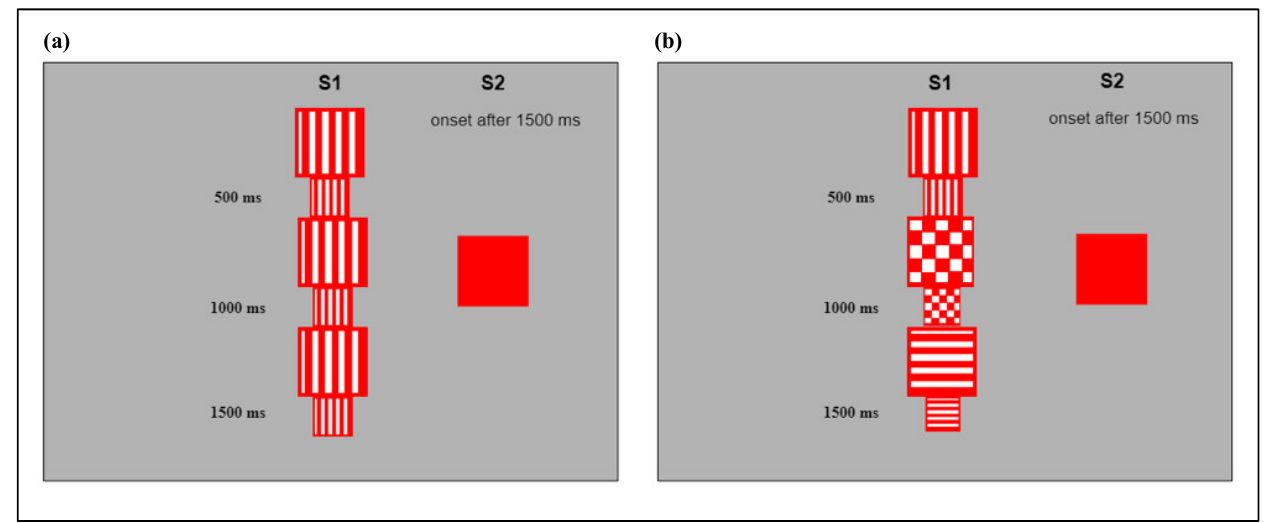
Figure 1. ( a ) Example of the central (S1) and peripheral (S2) stimuli presented during the simple condition; ( b ) Example of the central (S1) and peripheral (S2) stimuli presented during the complex condition.